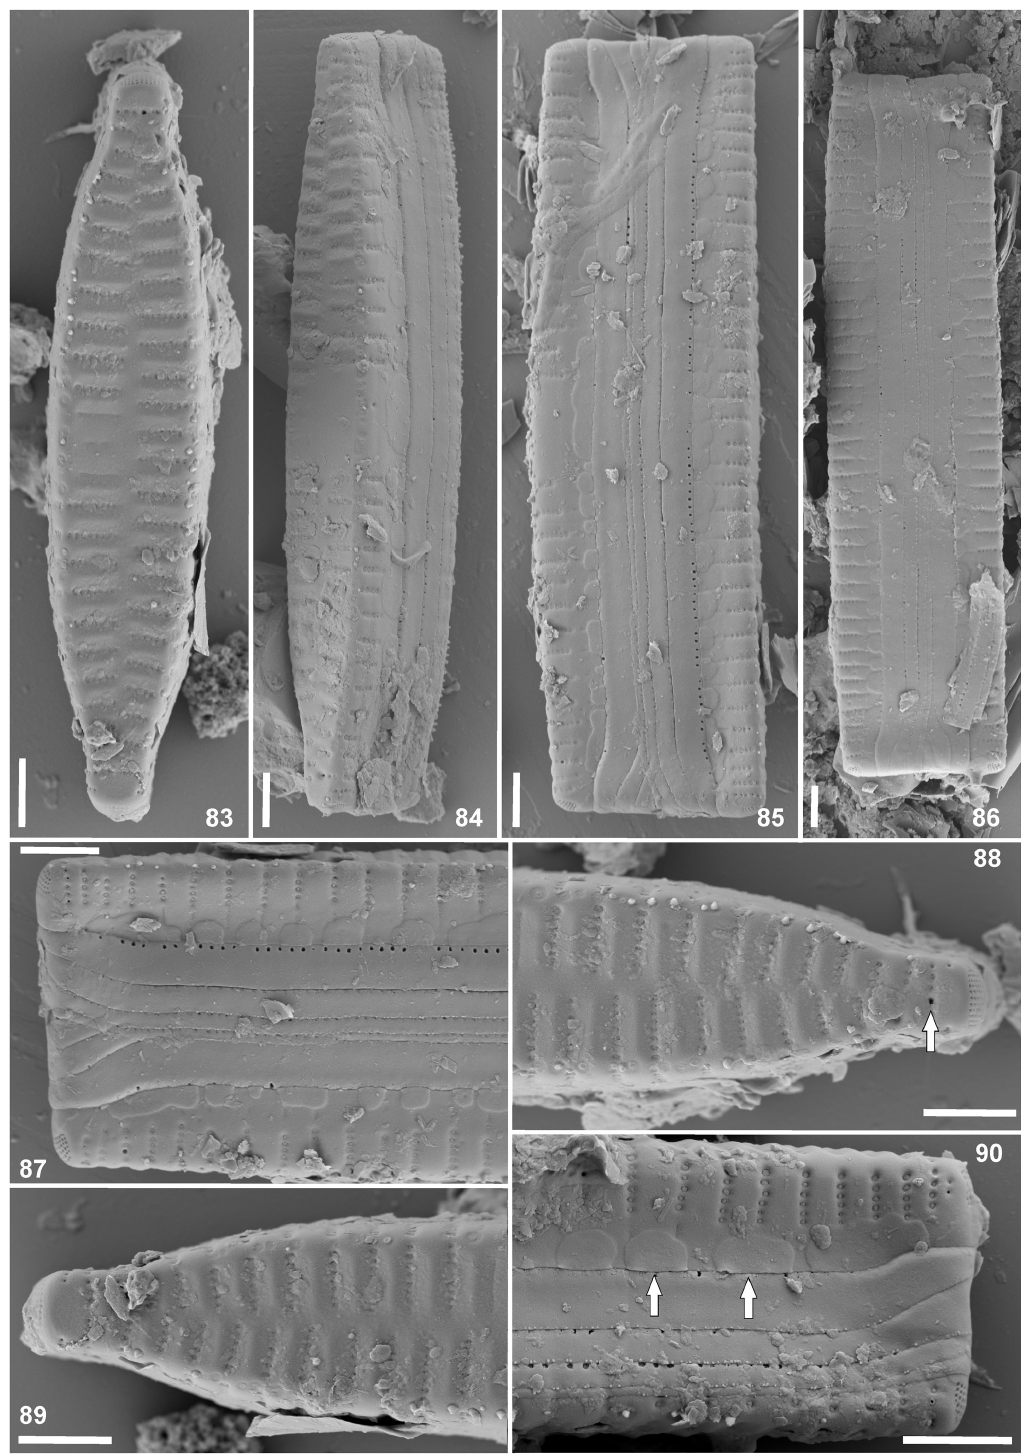
Figs 83-90. SEM micrographs of the type material of Fragilaria vaucheriae (Kütz.) J.B.Petersen . 83 . Complete valve in external view. 84 . Complete frustule in external view. 85–86 . Frustule in girdle view. 87, 90 . Detail of the apex in girdle view, with the girdle bands and fimbriae clearly visible (indicated by the arrows). 88–89 . Detail of the apex in external view (arrow indicates the rimoportula). Scale bars = 2